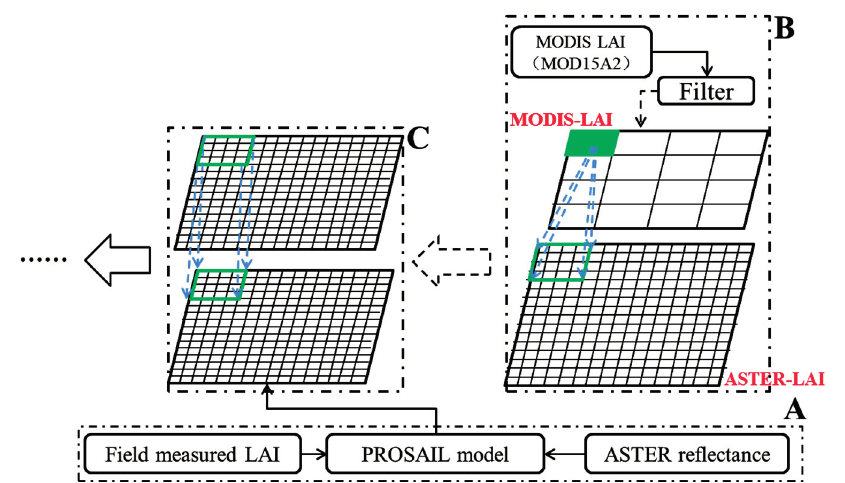
Figure 2. The diagrammatic chart for temporal, high-resolution leaf area index (LAI)